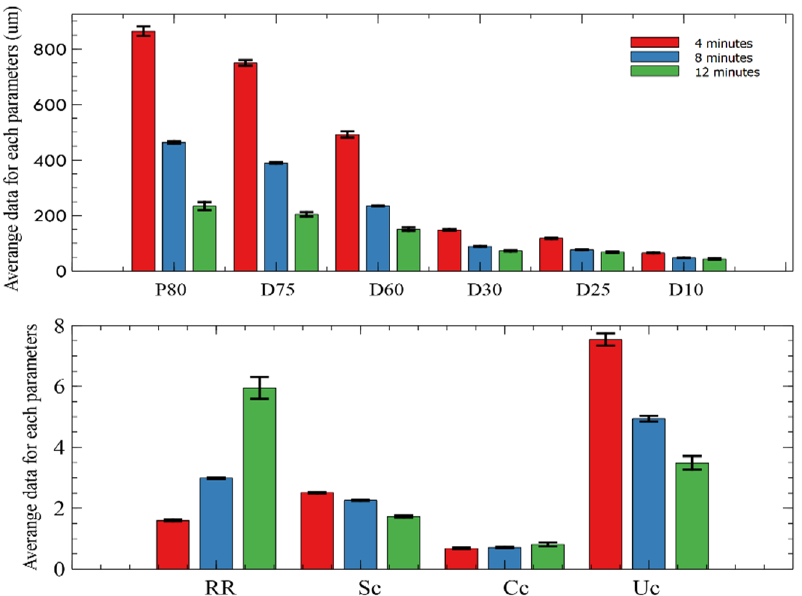
Figure 7. Evaluation of PSPC with 95% confidence. ( Above ) characteristic size; ( bottom ) characteristic parameters.